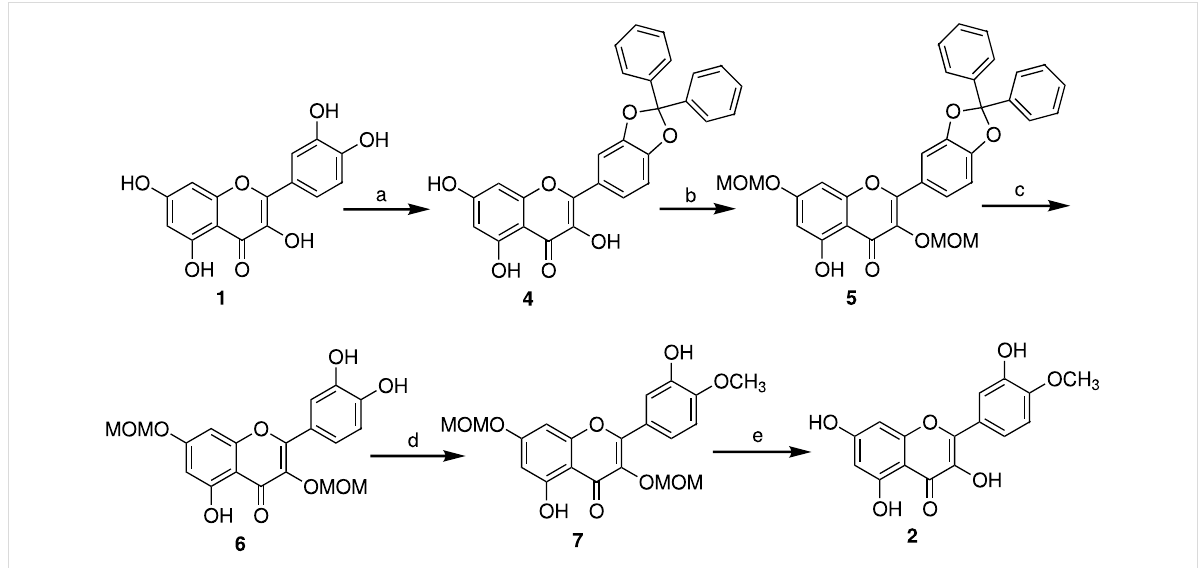
Scheme 1: Synthesis of 4′- O -methylquercetin ( 2 , tamarixetin). a) Ph 2 CCl 2 , Ph 2 O, 175 °C, 30 min, 86%; b) MOMCl, K 2 CO 3 , acetone, reflux, 6 h, 93%; c) Pd/C (10 wt %), H 2 (1 atm), THF/EtOH, 8 h, 95%; d) MeI, K 2 CO 3 , DMF, 8 h, 92%; e) HCl (1.0 M) in Et 2 O/CH 2 Cl 2 (1:1), 25 °C, 6 h,